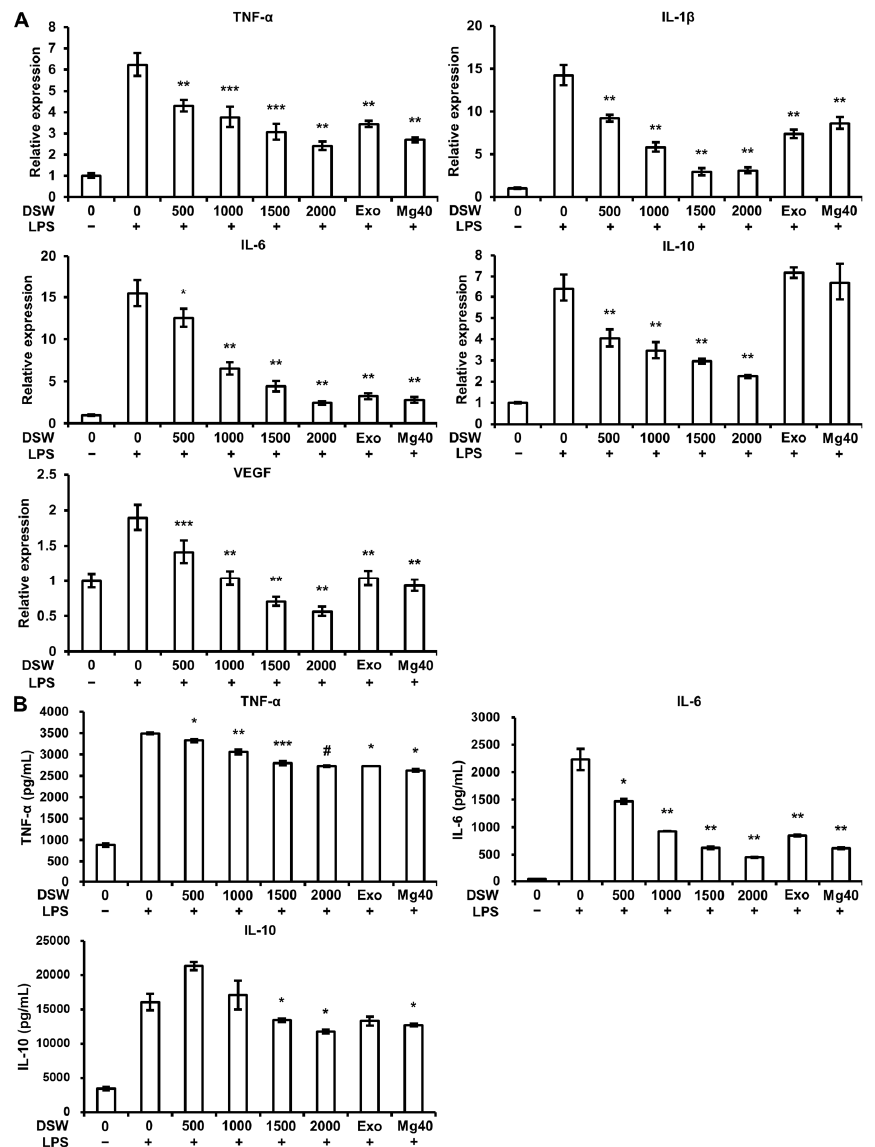
Figure 4. Effect of RDSW on LPS-induced pro-inflammatory cytokines expression and production, and VEGF expression. ( A ) The inhibitory effect of RDSW on TNF- α , IL-1 β , IL-6, IL-10, and VEGF mRNA expressions. GAPDH was used as an internal control for mRNA expressions. ( B ) The inhibition of the production of pro-inflammatory cytokines (TNF- α , IL-6, and IL-10) by RDSW. The amount of pro-inflammatory cytokines in the conditioned medium was measured by ELISA kits according to the manufacturer’s instructions and was normalized with the amount of total protein in each sample. All experiments were performed in triplicates, and all data are shown as the mean ± SD. * p < 0.05, ** p < 0.01, *** p < 0.001 and # p < 0.0001 compared to the LPS-induced control. Exo: hardness 1500 of exogenous Mg and Ca mixture, Mg:Ca = 3.5:1; Mg40: hardness 1500 of high Mg DSW, Mg:Ca = 40:1.